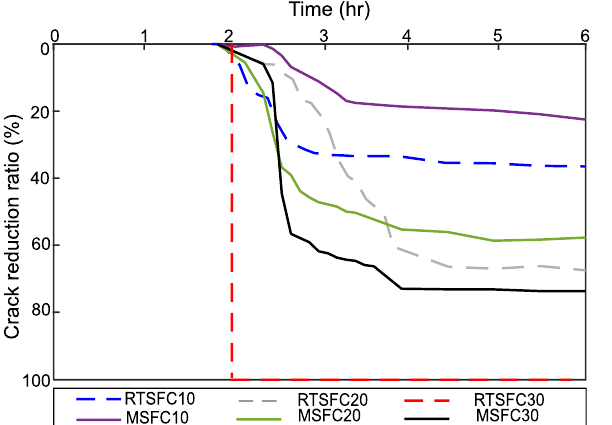
Figure 19. Evolution of crack reduction ratio (CRR) for specimens containing RTSF and MSF at 6 h.